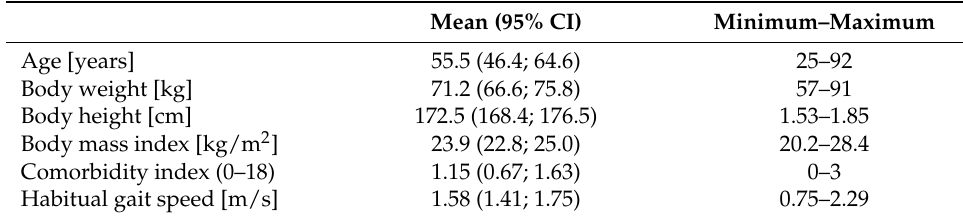
Table 1. Characteristics of all study participants ( n = 20).